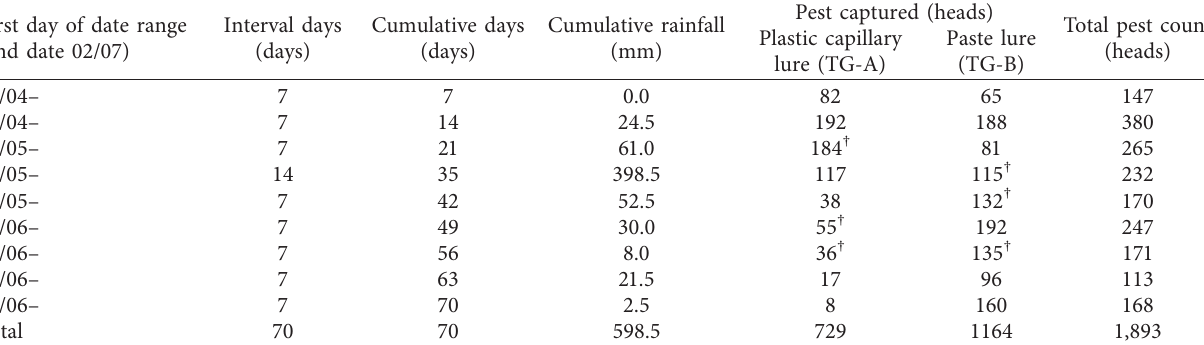
Table 1: Comparison of the attractiveness of different sex pheromone lures for capturing male rice stem borer in Changhua in 2015. First day of date